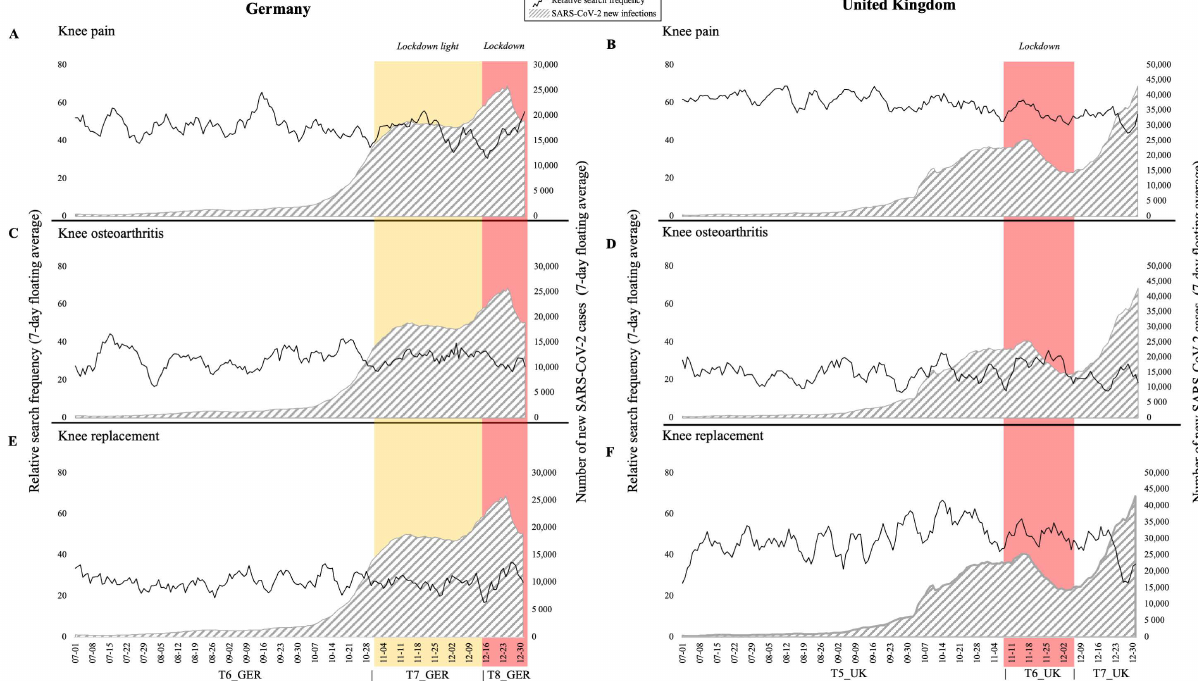
Figure 2. Public interest as relative search frequencies (black curve) of ( A , B ) knee pain, ( C , D ) knee osteoarthritis, and ( E , F ) knee prosthesis and number of new SARS-CoV-2 infections (grey, striped area) in the second half of 2020 in Germany and the UK, respectively. Relevant times frames are highlighted in color.